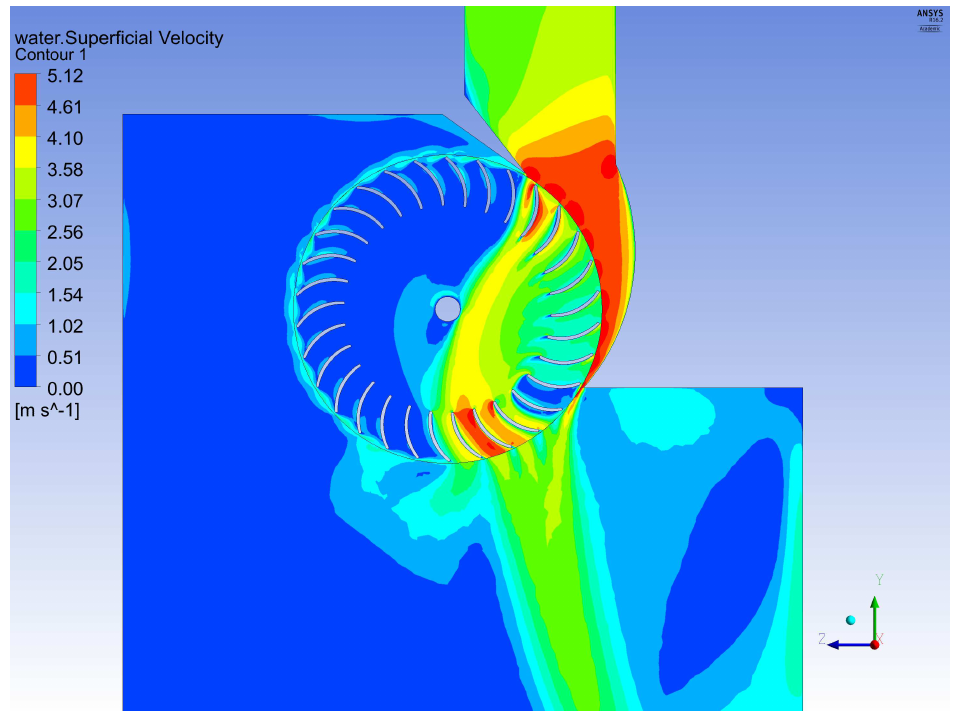
Figure 7. Contours of mean water velocity in the single-nozzle turbine at maximum efficiency [ Q max = 46 lps, H = 1.337 m, and ω max = 199 RPM]. Note that the flow is confined to less than 180 ◦ of the runner